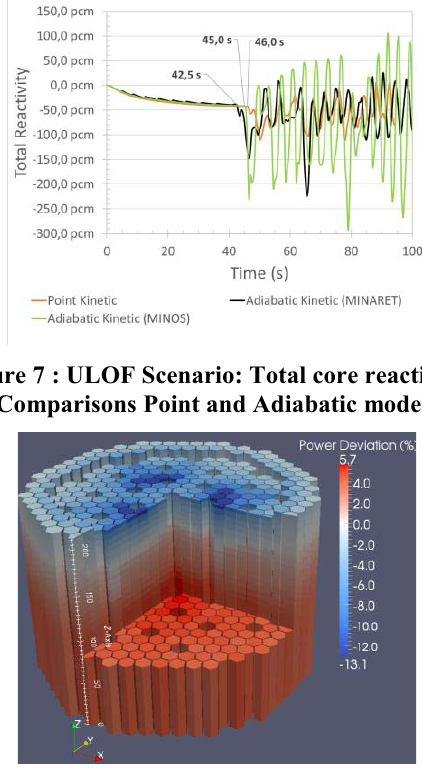
Figure 8 : Volume power map deviation - Boiling vs.